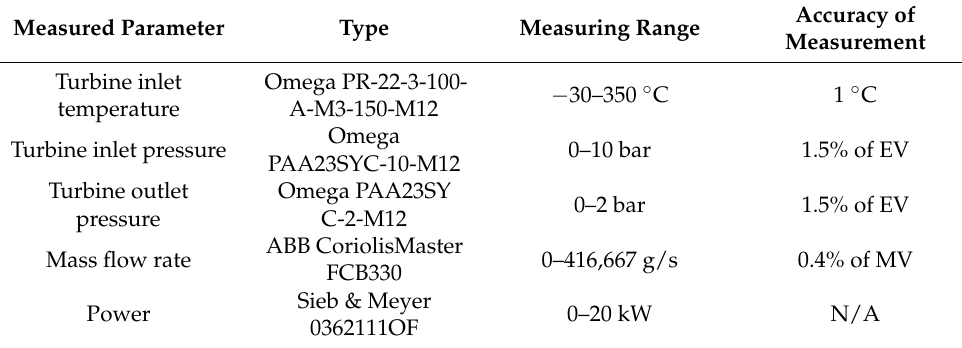
Table 3. Measuring range and accuracy of sensors for calculating the turbine efficiency. Measured Parameter